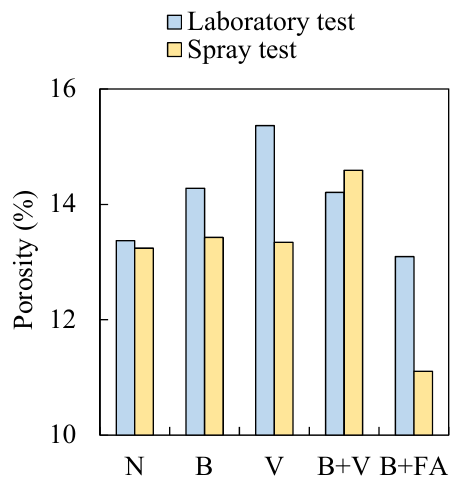
Figure 4. Porosity of mortar measured in spray test. Figure 5. Compressive strength of mortar measured in spray